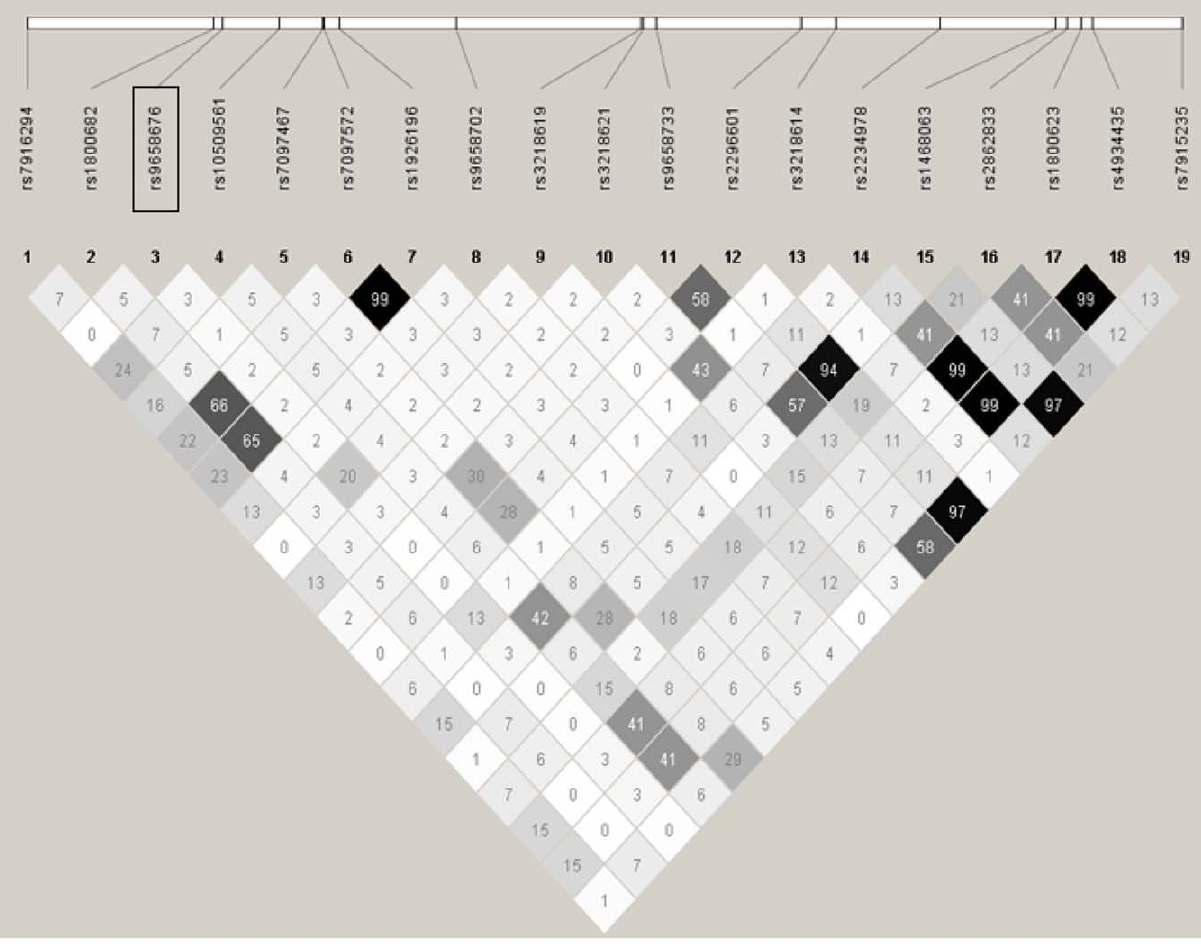
Figure 2. LD structure at the FAS gene locus. LD pattern is represented by pairwise r 2 values between SNPs with MAF . 5% based on genotypes from 1195 cases and 769 controls. r 2 values ( 6 100) for each comparison are given in the squares. White squares represent r 2 values equal to 0. Squares that are shades of grey represent r 2 values between 0 and 1.